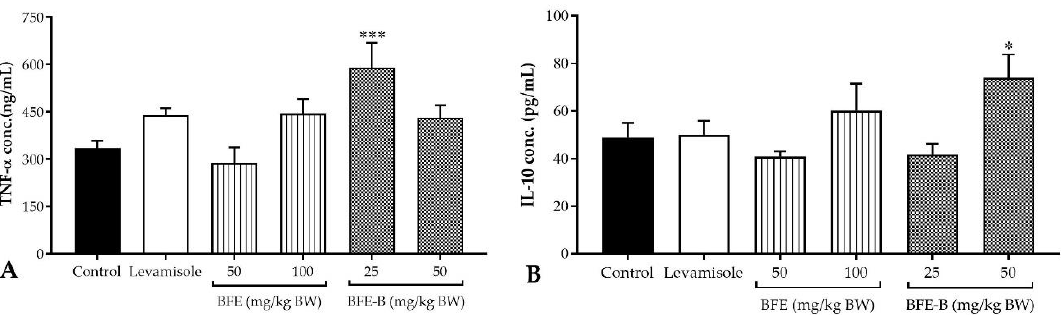
Figure 6. Effect of water-soluble fibers of P. erosus (BFE and BFE-B) on TNF-α ( A ) and IL-10 ( B ) production in mice induced by hepatitis B vaccine. The data represent the mean ± SEM of five independent measurements. Significant differences compared with the control are determined at * p < 0.05 and *** p < 0.001.